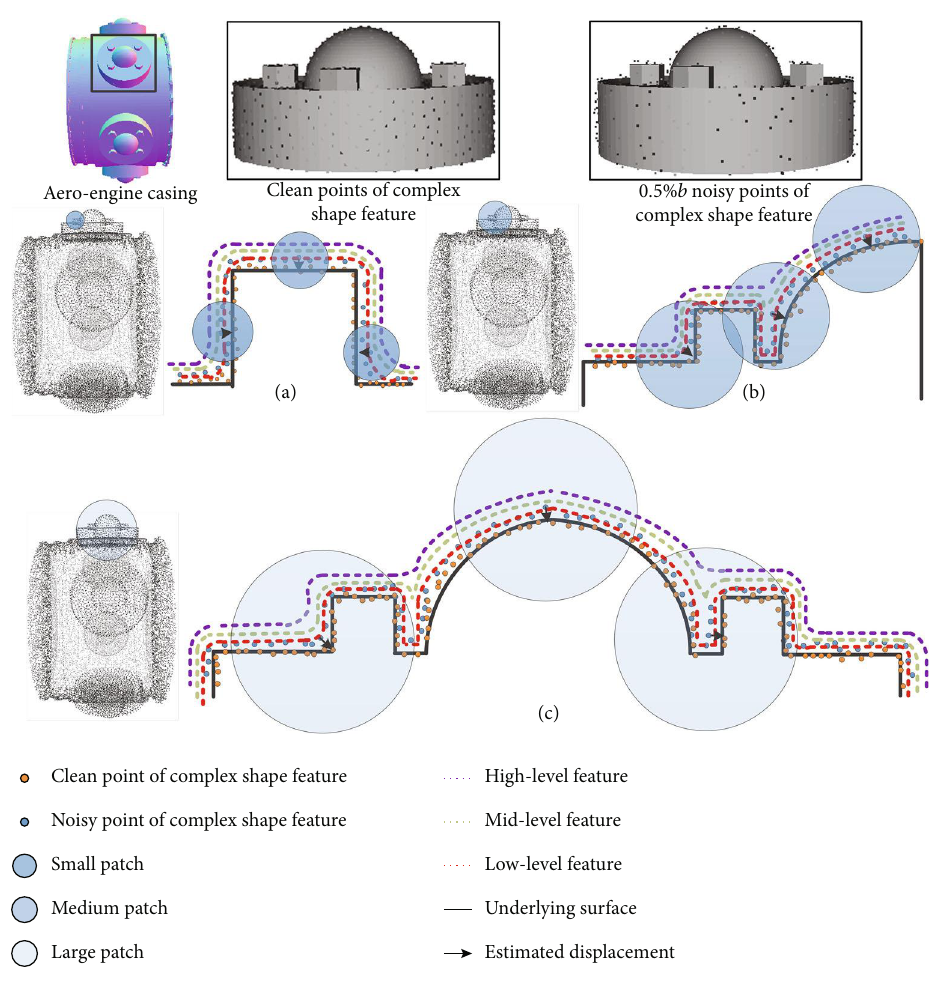
Figure 17: Illustration of complex shape feature